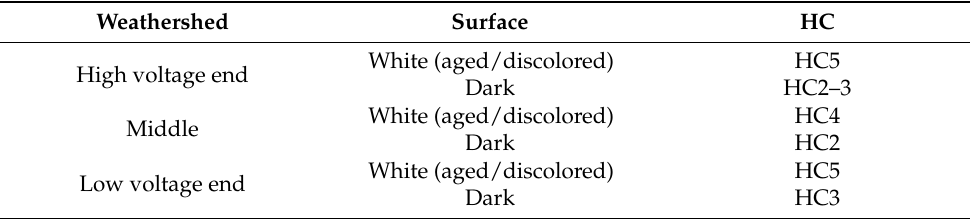
Table 2. HC of the 345 kV EPDM insulator [34].